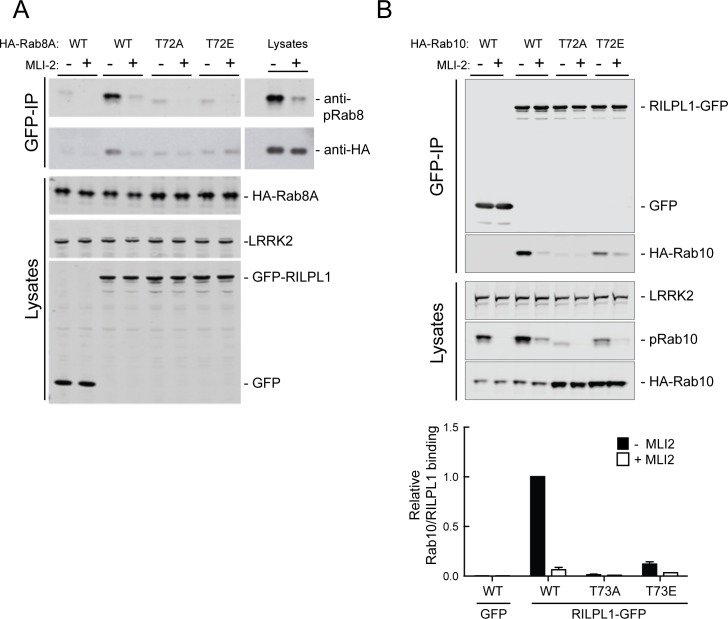
Phospho-site mutants of Rab8A and Rab10 bind RILPL1 poorly.HEK293T cells were co-transfected with Y1699C-LRRK2, phospho-site mutants of HA-tagged Rab8A (WT/T72A/T72E) (A) or HA-tagged Rab10 (WT/T72A/T72E) and GFP-RILPL1 or GFP alone. Cells were treated with MLi2 as indicated. Lysates were immunoprecipitated with anti-GFP antibody and immunoblotted for Rab8A or Rab10 using anti-HA antibody to detect total proteins. Total lysates were immunoblotted for anti-HA, anti-GFP and anti-LRRK2 (UDD3). Immunoprecipitation is indicated by GFP-IP analyzed by immunoblot using anti-HA antibody and anti-pRab8A or anti-pRab10 antibody for detecting phosphorylated protein. Graph at bottom quantified the relative amount of Rab10 that was bound to RILPL1 in panel B. Error bars represent SEM from three independent experiments.